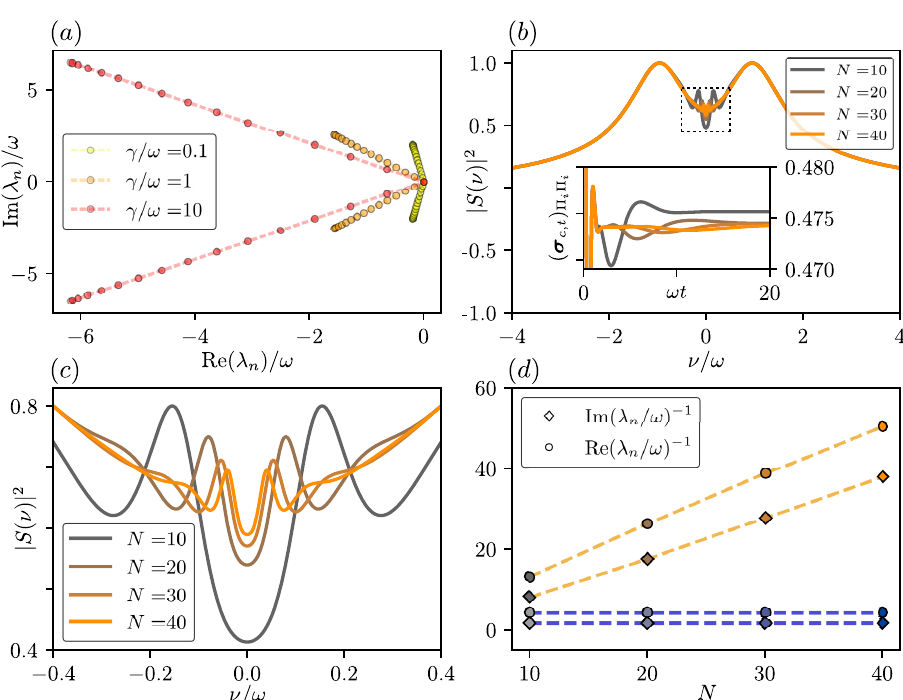
Figure 3: (a) Riccati spectrum for Π -measurements with different measurement = 0.95. The markers correspond to the numerical diago- strengths γ at fixed η 0 nalization of Eq. (59) for a system of size N = 30. The dashed lines corresponds to the analytical result in Eq. (60). (b) Inset: Quench dynamics under continuous Π -measurements for an initial mass quench with r = Ω /ω = 10 and η = 0.9 for 0 different system sizes N . Power spectrum for the quench dynamics of the inset. In (c) we zoom in on the region in the dashed box. The finite size scaling of the width